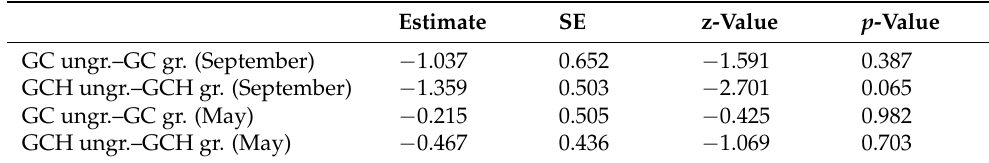
Table A30. Differences in activity densities of flightless/immobile carabid beetles, comparing the grazed pastures and ungrazed strips of the grass–clover (GC) and the grass–clover herbs (GCH) in